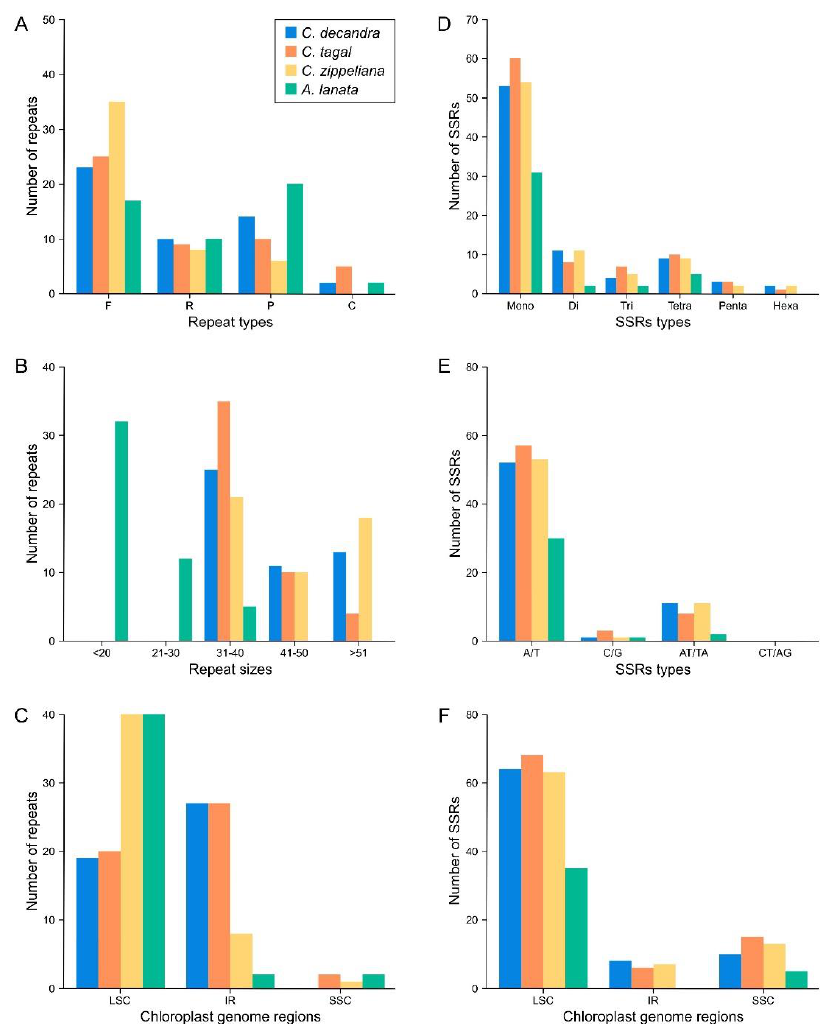
Figure 4. Statistical analysis of repeats and SSRs in four mangrove chloroplast genomes. ( A ) Sorted by type of repeat. ( B ) Frequency by repeat types. ( C ) Sorted by repeat region of genome. ( D ) Sorted by type of SSR. ( E ) Frequency by SSR type. ( F ) Sorted by SSR region of genome. Table 3. Number of SSRs in the chloroplast genomes of three Ceriops and two Avicennia species.